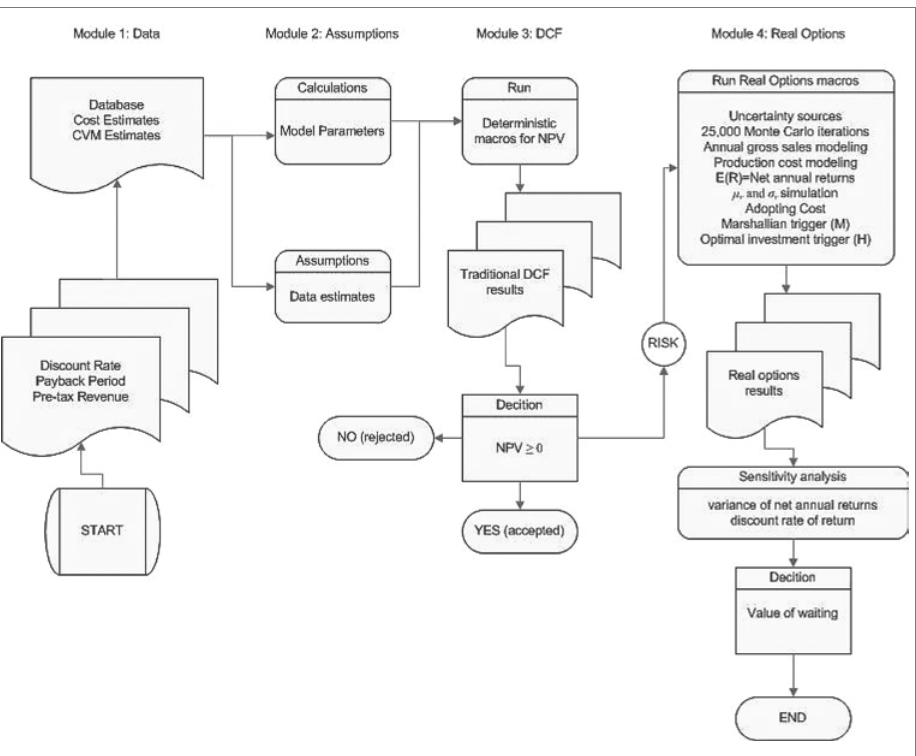
Fig. 2. Diagram of the flow chart of the